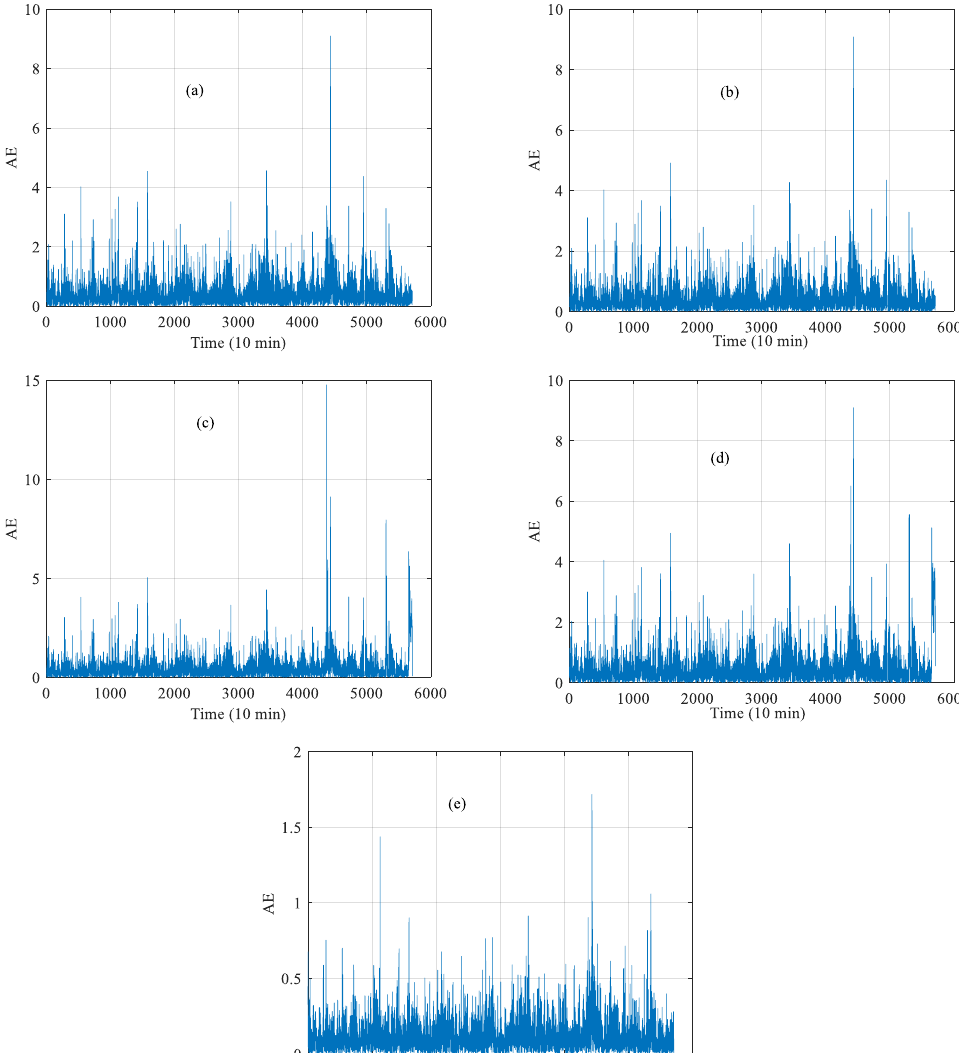
Figure 7. Absolute Error per time frame of the proposed model corresponding at ( a ) Case#1, ( b ) Case#2, ( c ) Case#3, ( d ) Case#4, ( e ) Case#5 of the 10-min-ahead prediction horizon.